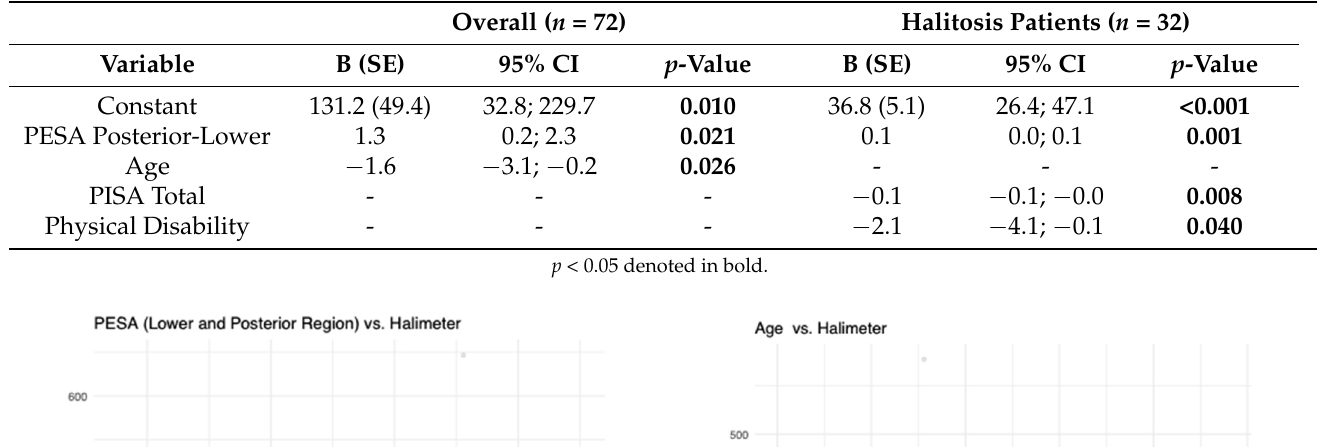
Table 4. Stepwise multivariate linear regression analysis of age and PESA posterior-lower teeth for the outcome variable of VSCs ( n = 405).